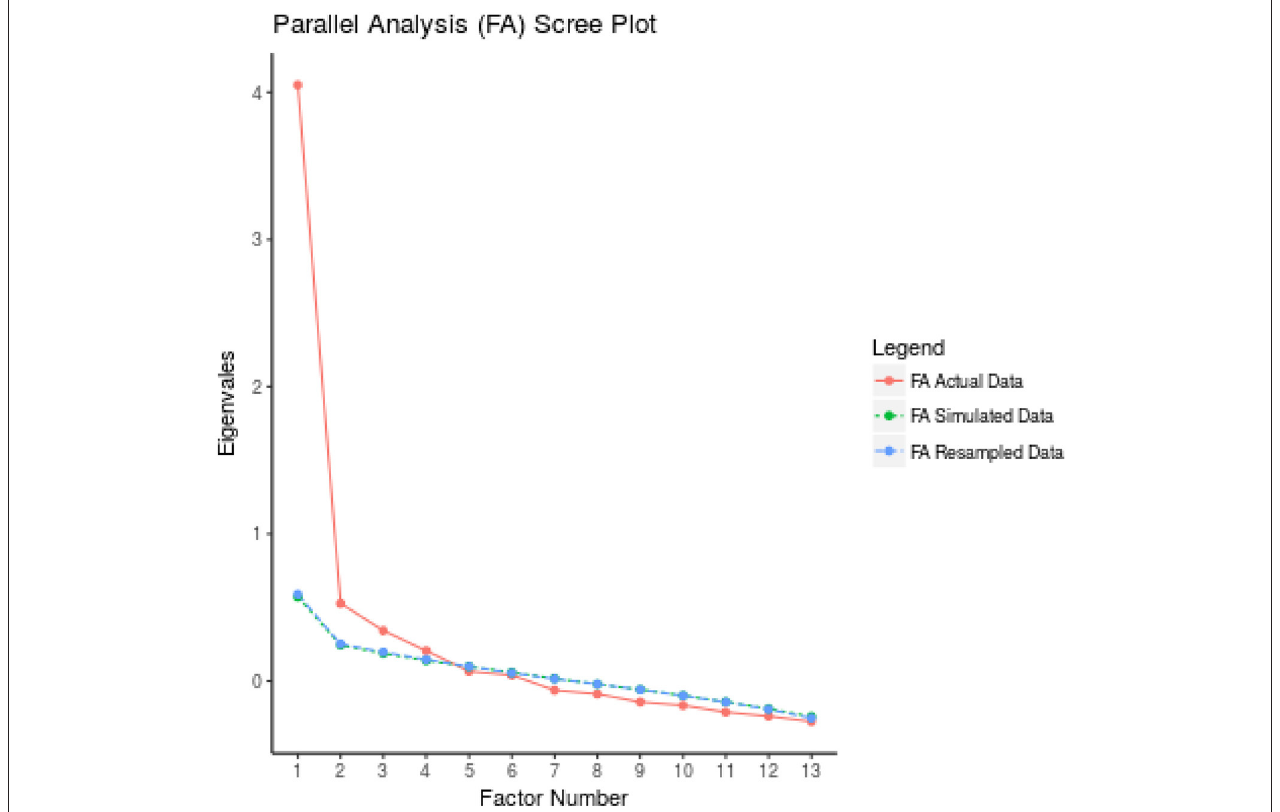
FIGURE 1 | Parallel analysis scree